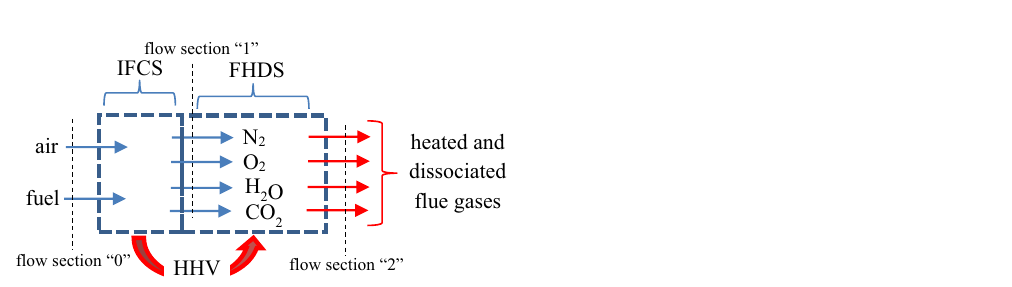
Figure 11. The scheme of the combustion